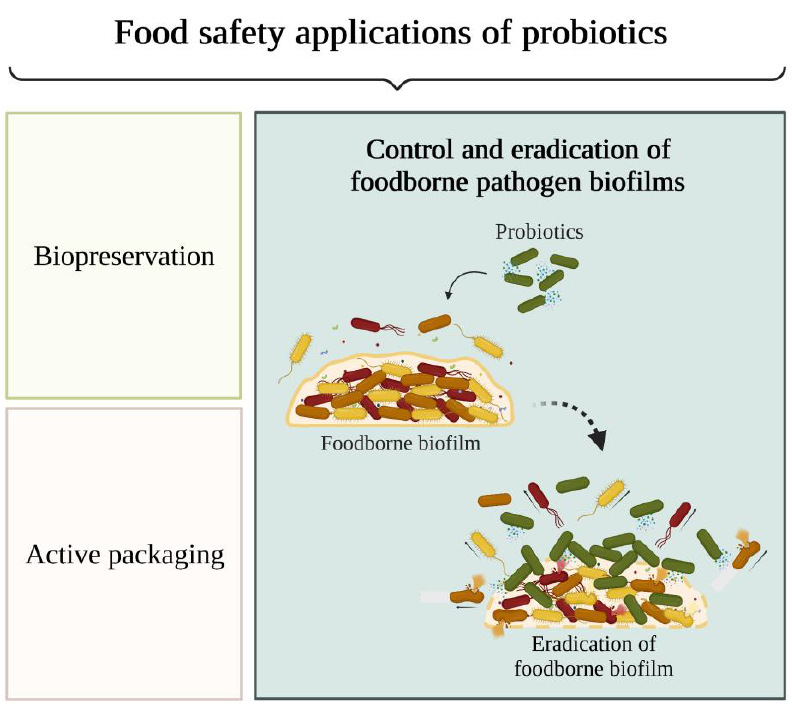
Figure 1. Food safety applications of probiotics: preservation, packaging, and control and eradication of foodborne pathogen biofilms.